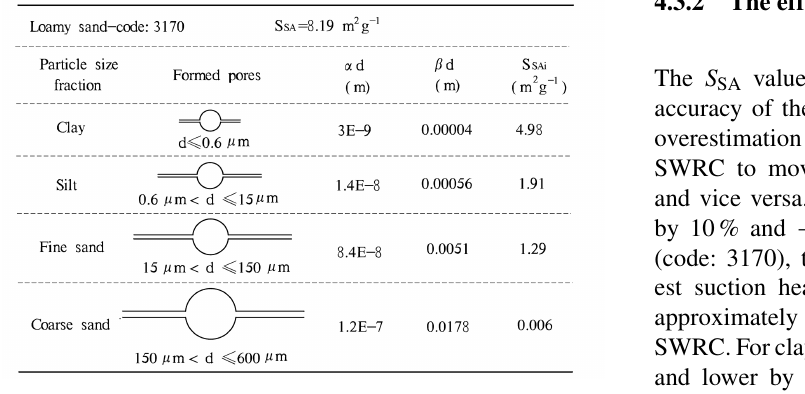
Figure 8. The calculated slit width αd , slit length βd and S SA i for loamy sand (code: